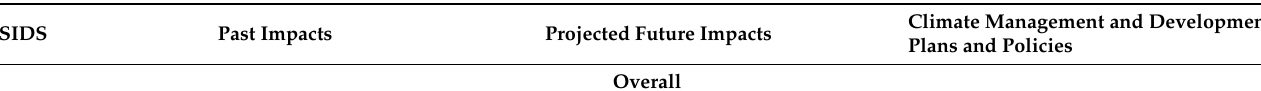
Climate Management and Development Plans and